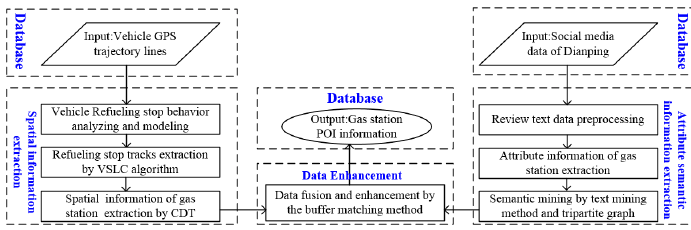
Figure 1. General workflow of gas station information enhancement.